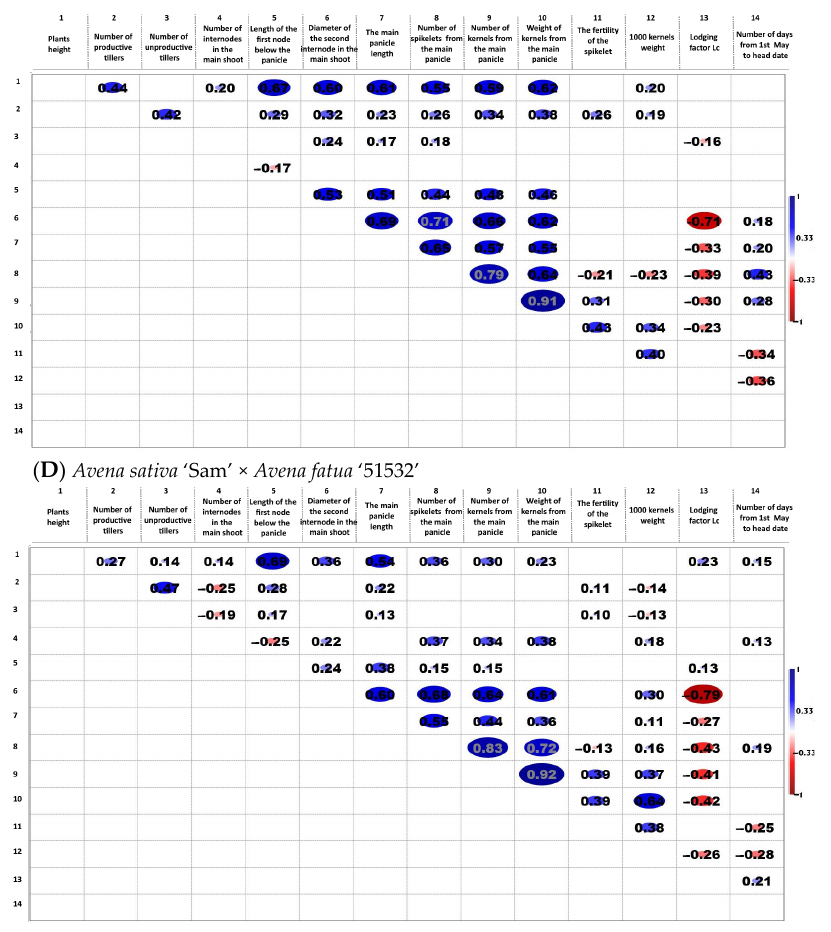
Figure 1. Heatmaps of Spearman’s correlation coefficient ( r ) showing association of agronomic traits evaluated across ( A ) Avena sativa cv. Sam and ( B ) Avena fatua ‘51532’, as well as ( C , D ) their F2 populations and ( E ) full dataset. Blue colours represent positive correlation, while red show negative correlation. R values with p > 0.05 are blank. The size of the ellipses corresponds to the correlation level. R > 7.0 is in gray.